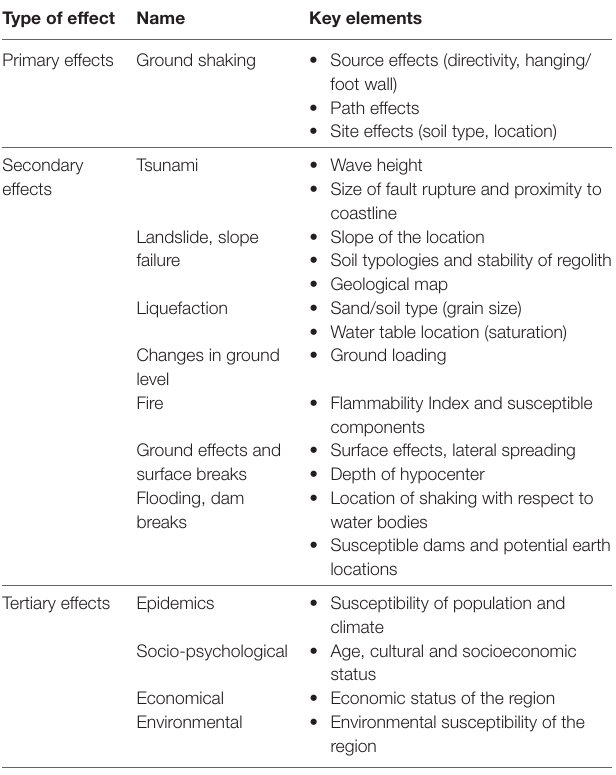
Table 1 | The process of primary, secondary, and tertiary effects of